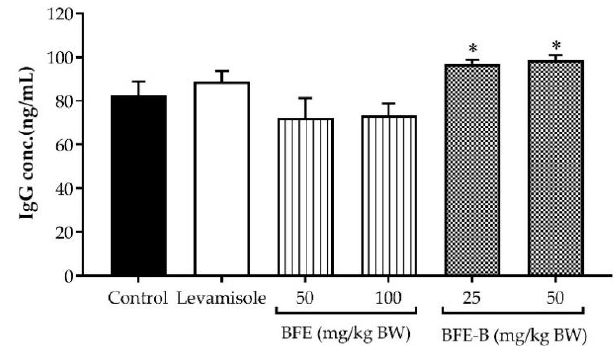
Figure 7. Effect of water-soluble fibers of P. erosus (BFE and BFE-B) on IgG production in mice induced